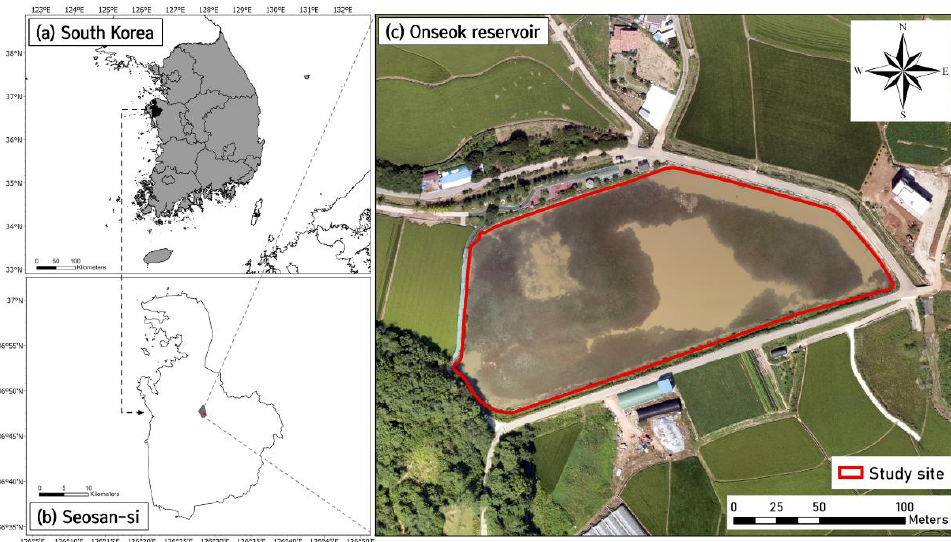
Figure 1. Map showing the location and red outline of the study site (Onseok reservoir). ( a ) South Korea, ( b ) Seosan-si, Chungcheong-namdo, and ( c ) Onseok